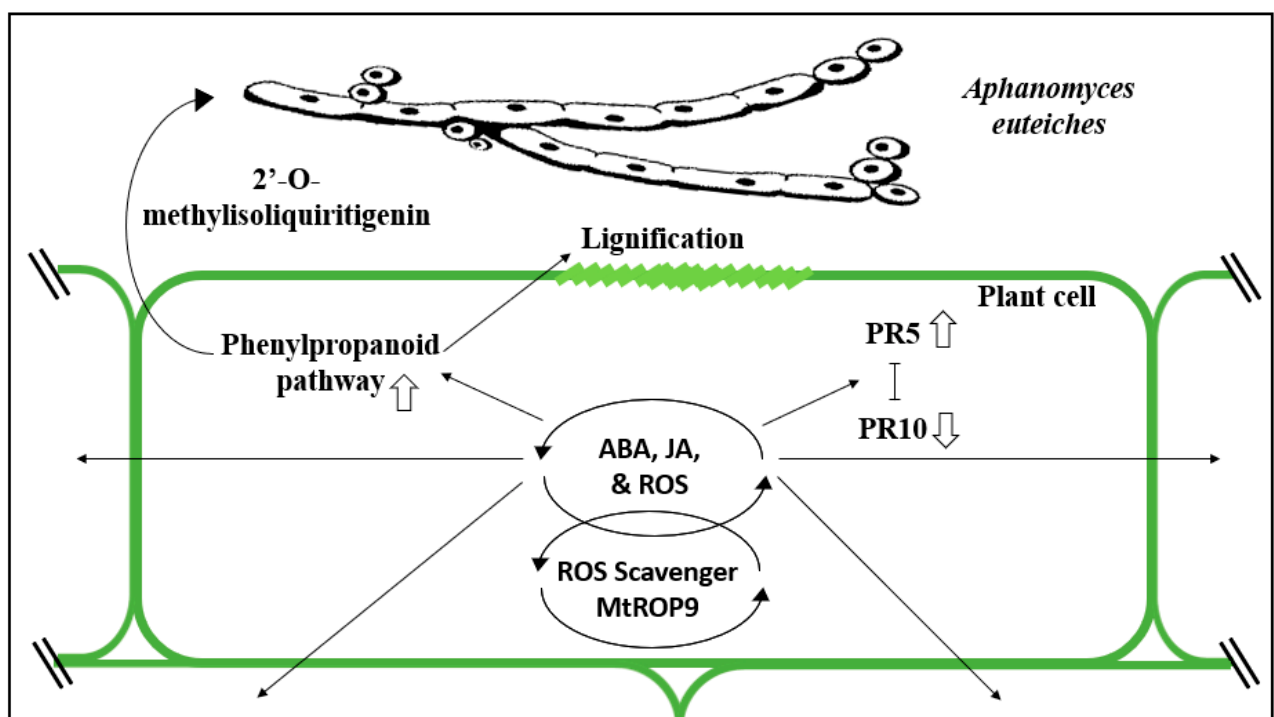
Figure 3. A model representing a resistance response following inoculation with Apahanomyces euteiches in Medicago truncatula . Events include the synthesis and signaling of abscisic acid (ABA) and reactive oxygen species (ROS). ROS are regulated by a small GTPase, named MtROP9. ABA and ROS signaling result in the overexpression of PR5 gene and the phenylpropanoid pathway. The lignification and synthesis of 2 ′ -O-methylisoliquiritigenin are positively correlated with disease resistance against A. euteiches. 2 ′ -O-methylisoliquiritigenin was shown to significantly impede A. euteiches development and zoospore germination. Model derived from results presented in Badis et al., (2015); Colditz et al., (2004); Djébali et al., (2009); Leonard M Kiirika et al., (2014); Leonard Muriithi Kiirika et al., (2012); Nyamsuren et al., (2003); Trapphoff et al., (2009) [344–350].